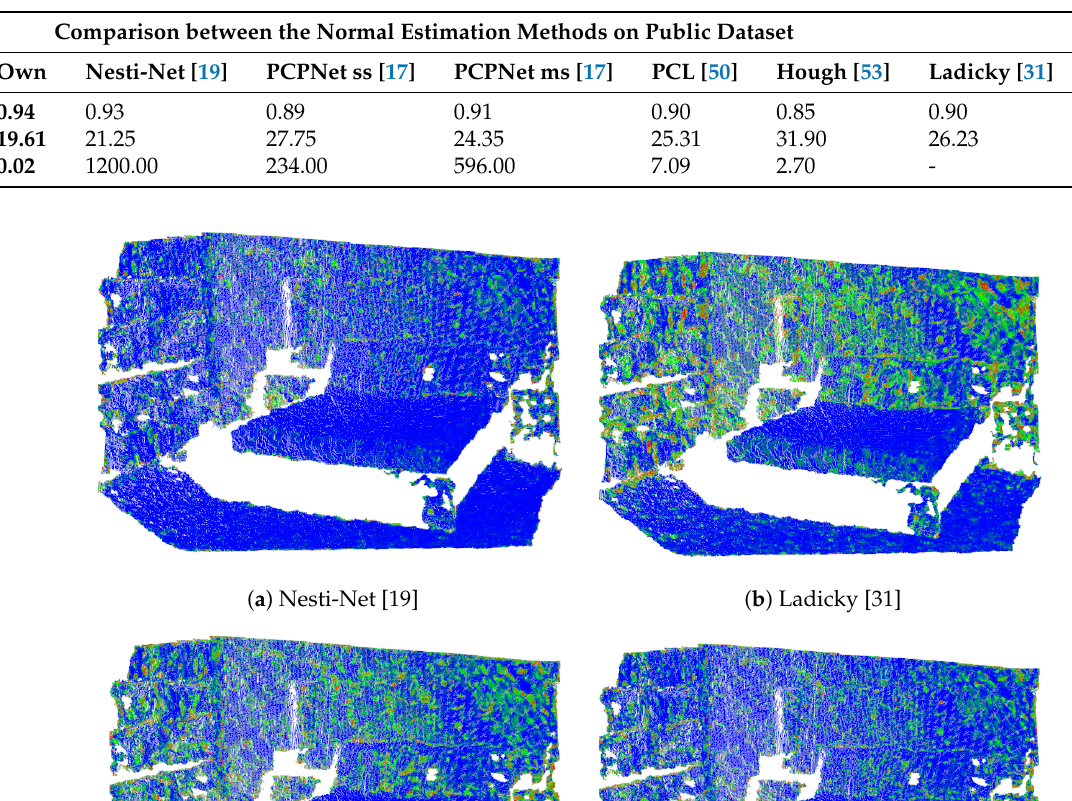
Table 1. Summary of the comparison with other methods.